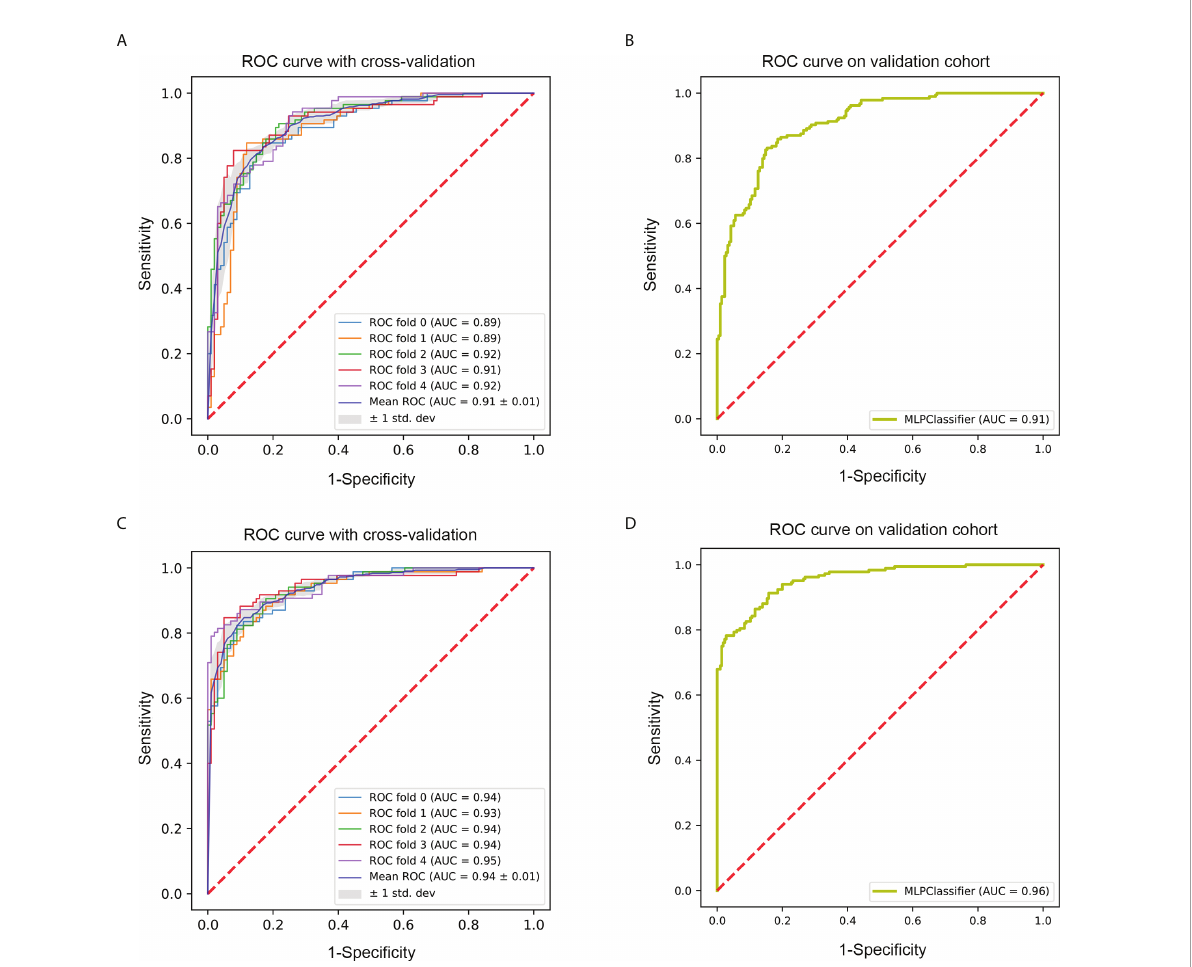
FIGURE 5 ROC curve of the optimal classi fi er (MLP). (A) The fi vefold cross-validation ROC curve of radiomics model with MLP classi fi er in the training cohort. (B) The ROC curve of radiomics model with MLP classi fi er in the validation cohort. (C) The fi vefold cross-validation ROC curve of mixed model with MLP classi fi er in the training cohort. (D) The ROC curve of mixed model with MLP classi fi er in the validation cohort. ROC, receiver- operating characteristic; MLP, multi-layer